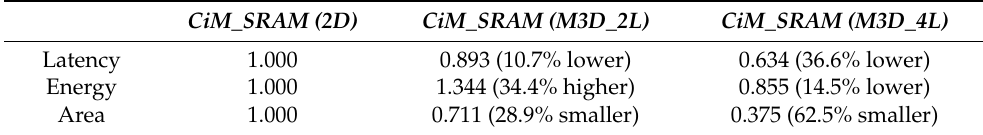
Table 2. Normalized results of CiM_SRAMs in terms of latency, energy, and